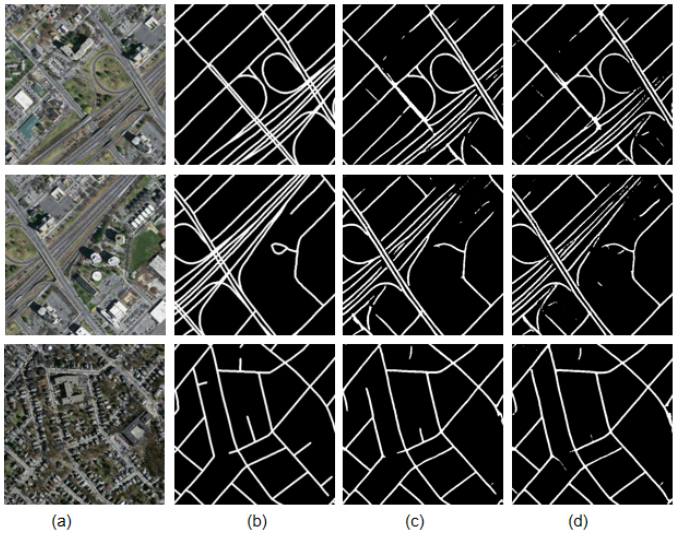
Figure 17 . Comparison results of complex scene experiment. ( a ) Input image; ( b ) label image; ( c ) D-LinkNet_50; and ( d ) D-LinkNet_101.